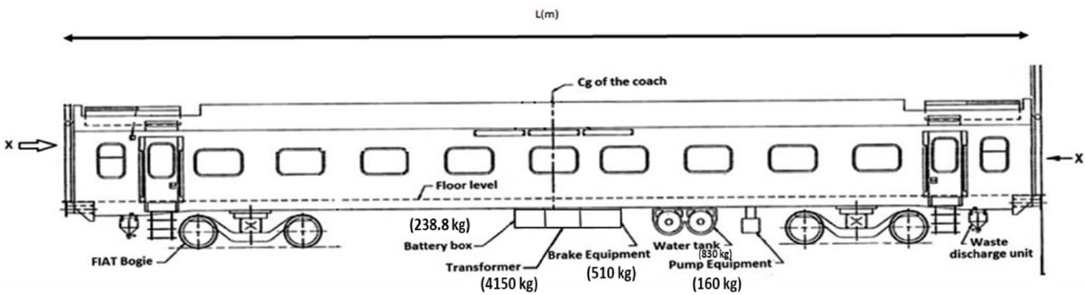
Figure 1. Schematic model of the passenger rail–vehicle LHB coach.